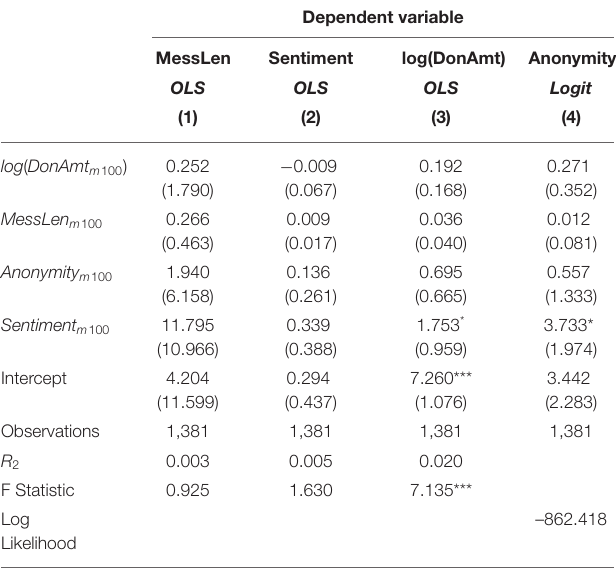
TABLE 6 | The placebo regression results of donation